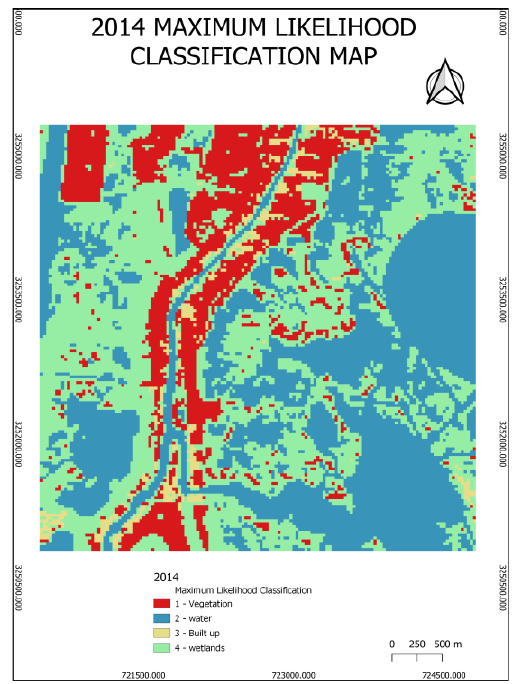
Fig.3 A 2014 map showing land use classes for Dulac